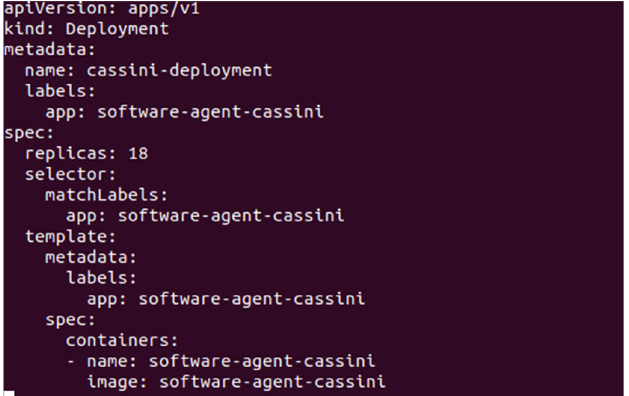
Figure 4. Containers deployment configuration script for